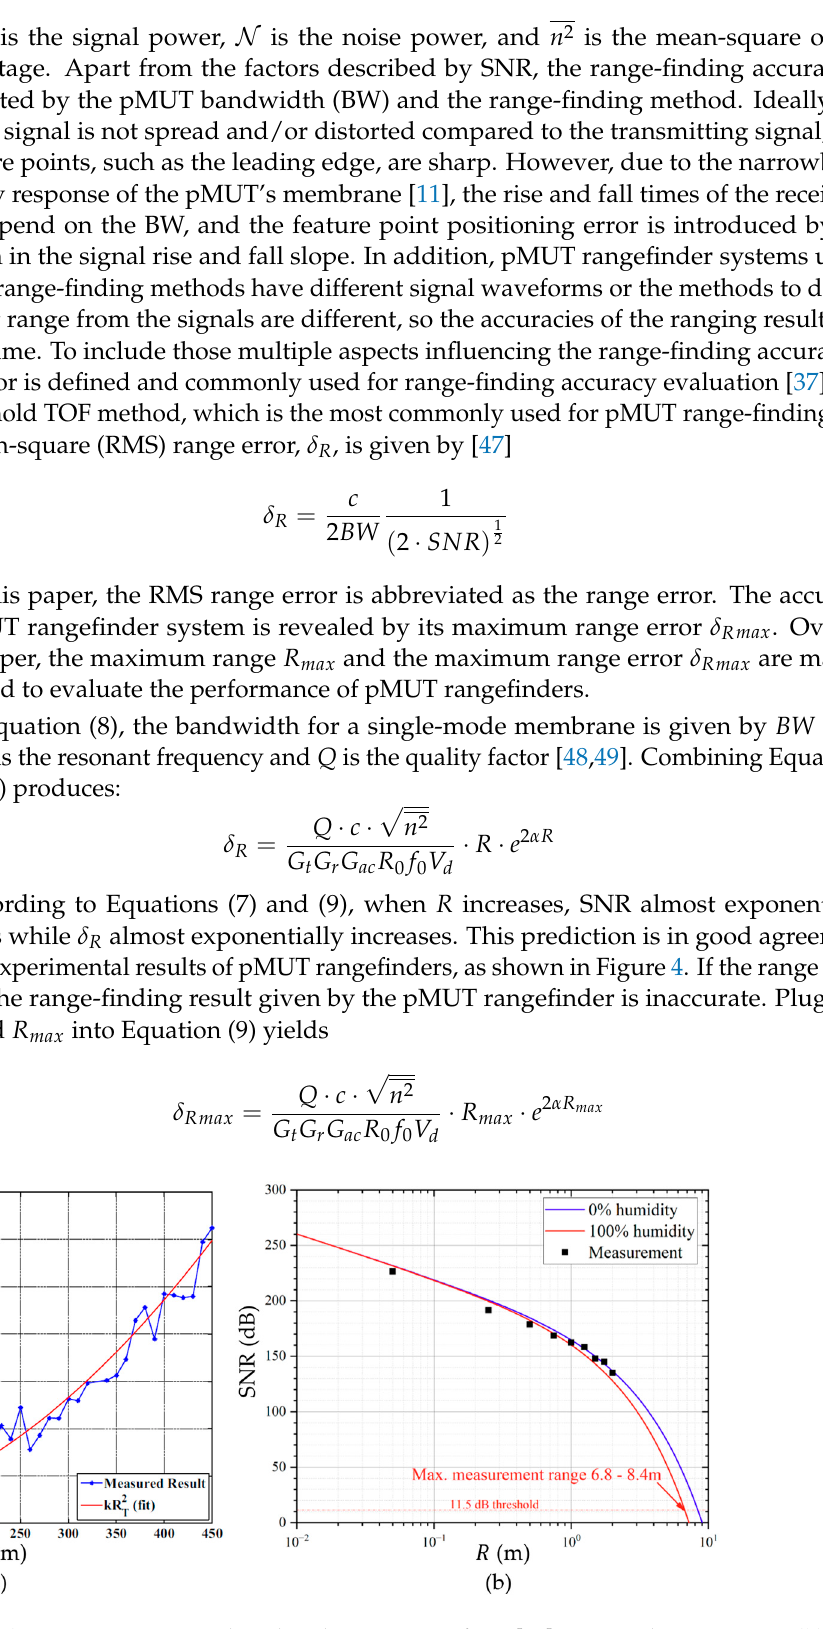
Figure 4. ( a ) δ R versus R . Reproduced with permission from [33], Copyright 2010, IEEE. ( b ) SNR versus R . Reproduced with permission from [31], Copyright 2022, MDPI